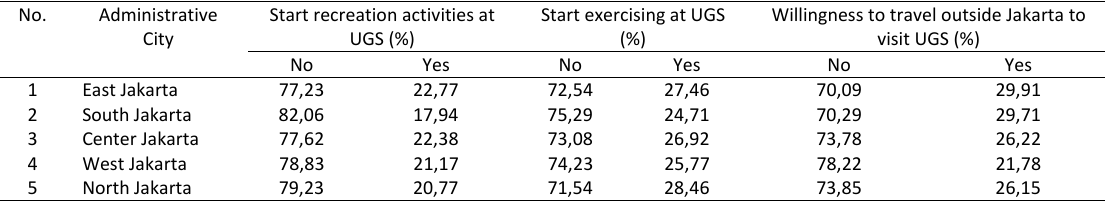
Table 4: Respondents’ perceptions of UGS visitation during the COVID-19 pandemic in Jakarta No.